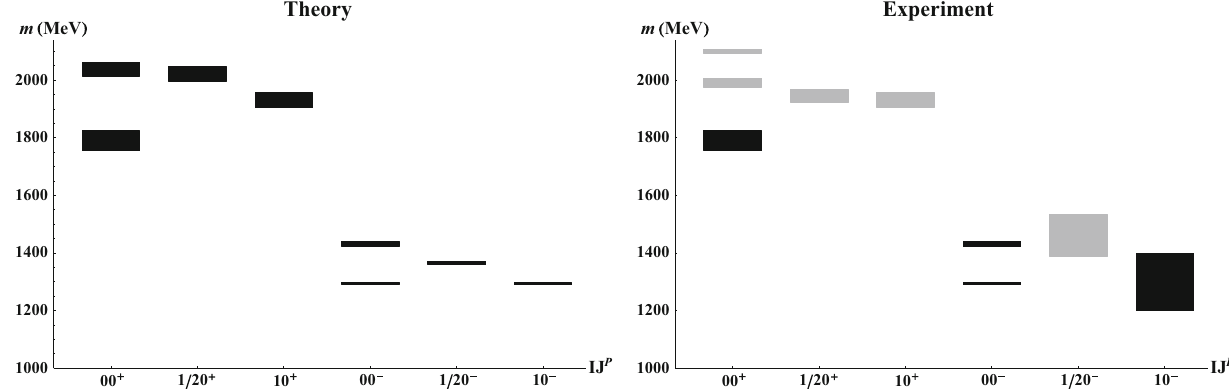
) states from the left panel were used as input. as well as the 10 + ( ≡ a E 0 Lightly shaded areas correspond to experimentally as yet unestablished states. Table 6 contains the experimental assignment of the states on the ) ,both00 − ( ≡ η E ) left panel and a brief overview of their and η E N N S